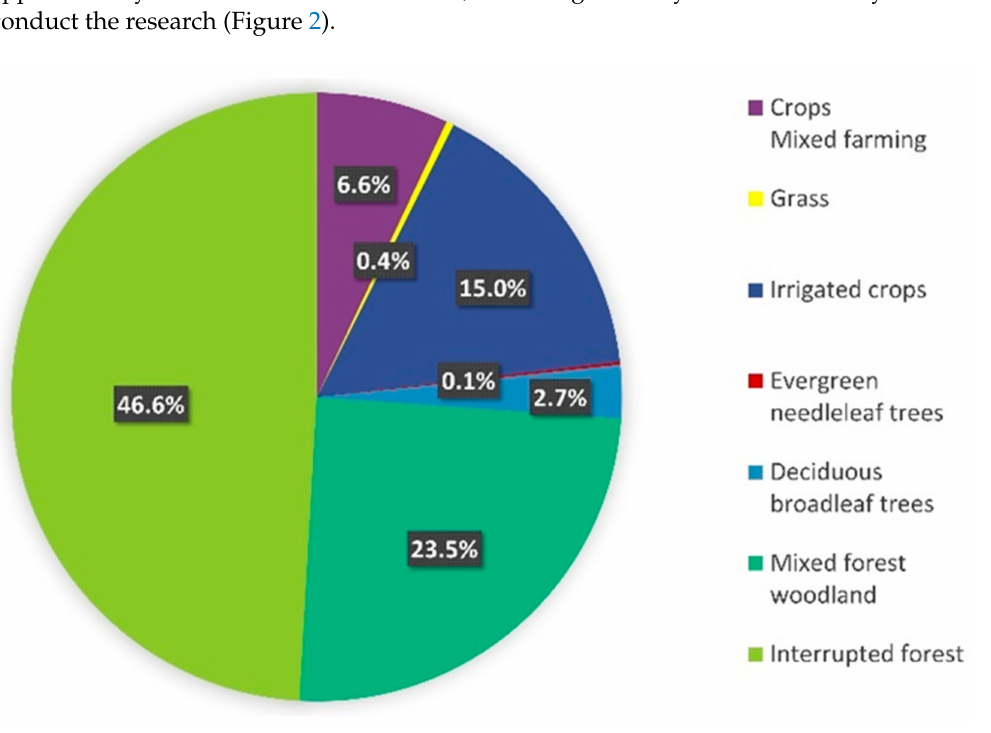
Figure 2. Vegetation fractions in the Korean Peninsula according to ERA5